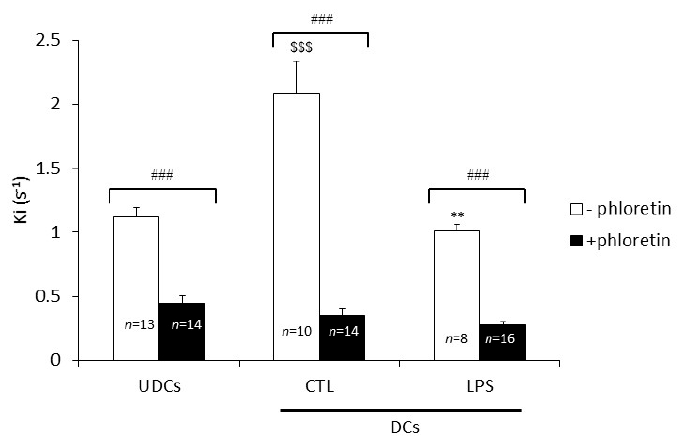
Figure 3. Relative contributions of the facilitated (aquaglyceroporin-mediated) and simple diffusion (phospholipid bilayer) flow through the plasma membrane to the glycerol permeability of UDCs, untreated DCs (CTL) and LPS-treated DCs (LPS). The Ki (s − 1 ) values, an index reflecting the membrane glycerol permeability, were determined by stopped-flow light scattering analysis of plasma membrane vesicles prepared from UDCs, untreated DCs (CTL-DCs) and LPS-treated DCs (LPS-DCs) in the absence or presence of phloretin (0.7 mM, 10 min). The results are the mean ± S.E.M. of the Ki values of 8 to 14 independent vesicle preparations. Data were analyzed using One-way ANOVA and Bonferroni post-hoc t -test. ### p < 0.001 vs. phloretin; $$$ p < 0.001 vs. UDCs; ** p < 0.01 vs. CTL.